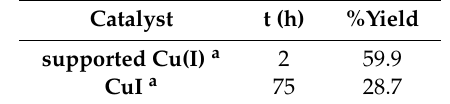
Table 2. Results of synthesis of compound 5 catalyzed by supported Cu(I) and free